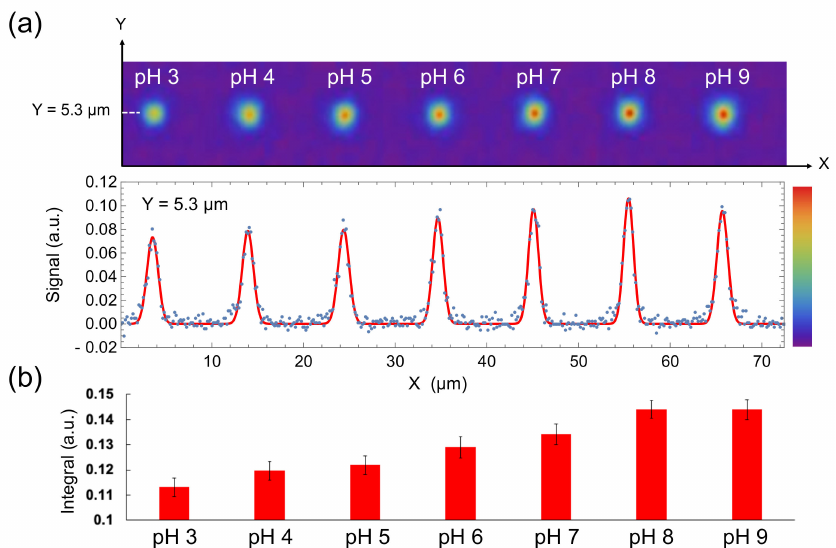
Figure 4. ( a ) T 1 -weighted images of a 100-nm nanodiamond in various pH condition (top) and its signal intensity in Y = 5.3 µ m plotted against X (bottom). Red line represents the fitting function, which contains seven gaussian functions. ( b ) Definite integrals of the fitted gaussians in each pH condition. Error bars represent the standard error of the gaussian